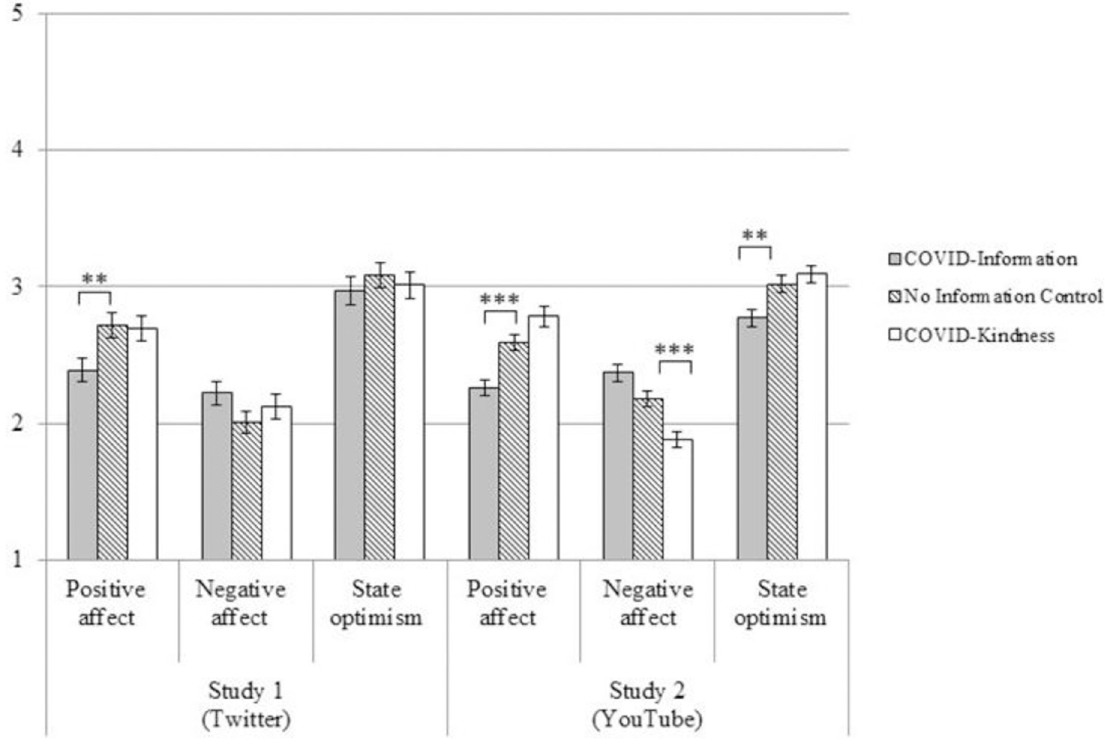
Fig 1. Impact of condition on well-being for Studies 1 and 2. Shown are the results from post-hoc pairwise t-tests depicting well-being differences between the no information control condition and the COVID-kindness and COVID-information conditions. Error bars represent standard errors. �� p < .01, ��� p <